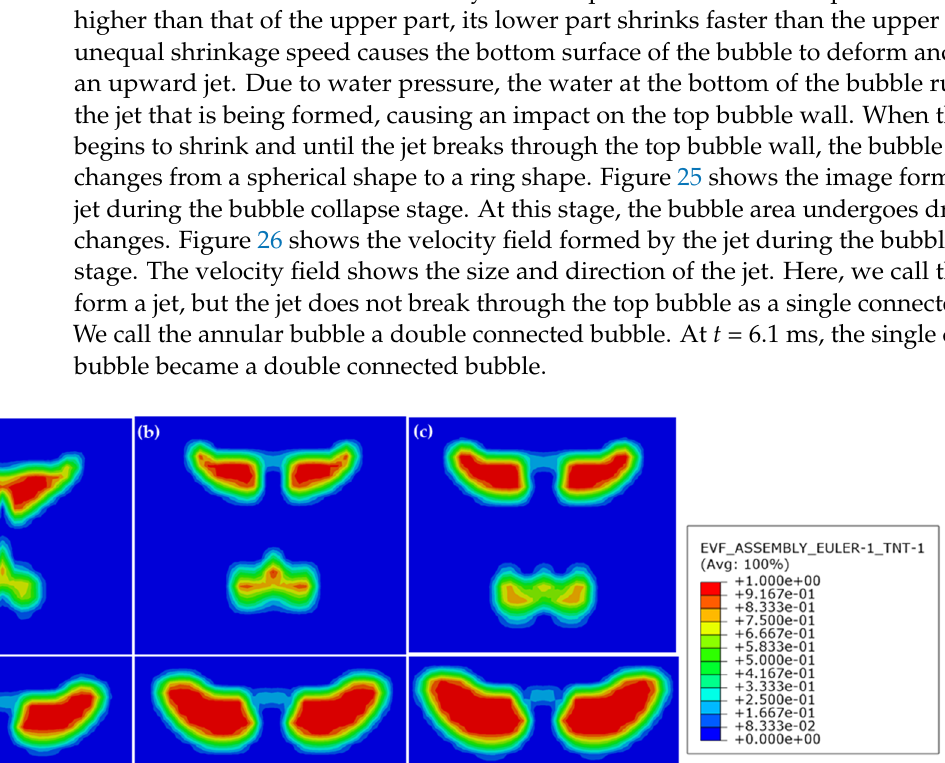
Figure 24. The position of the upper bubble surface and the lower bubble surface.